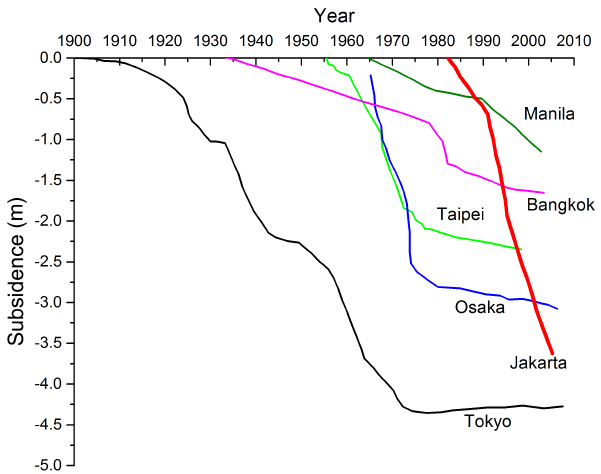
Figure 1. Land subsidence in Asian megacities (Kaneko and Toy- ota, 2011; Takagi et al.,